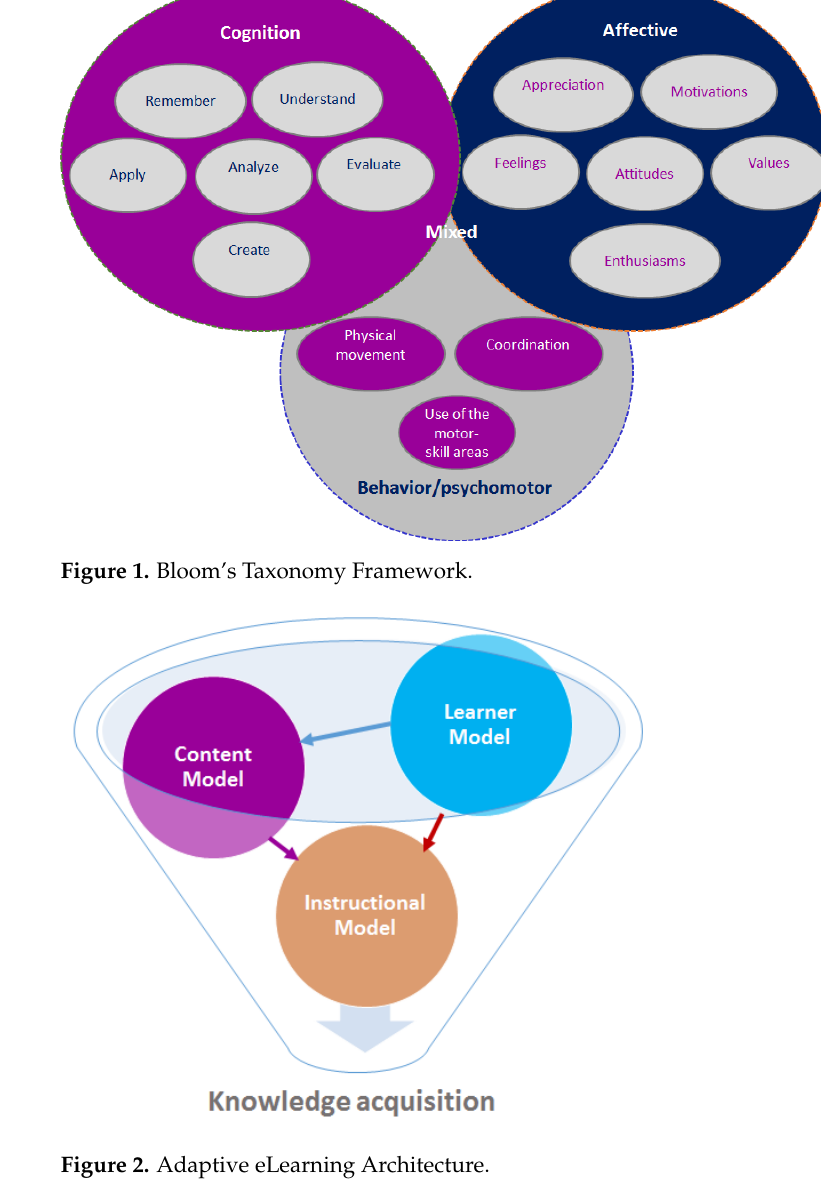
Figure 2. Adaptive eLearning